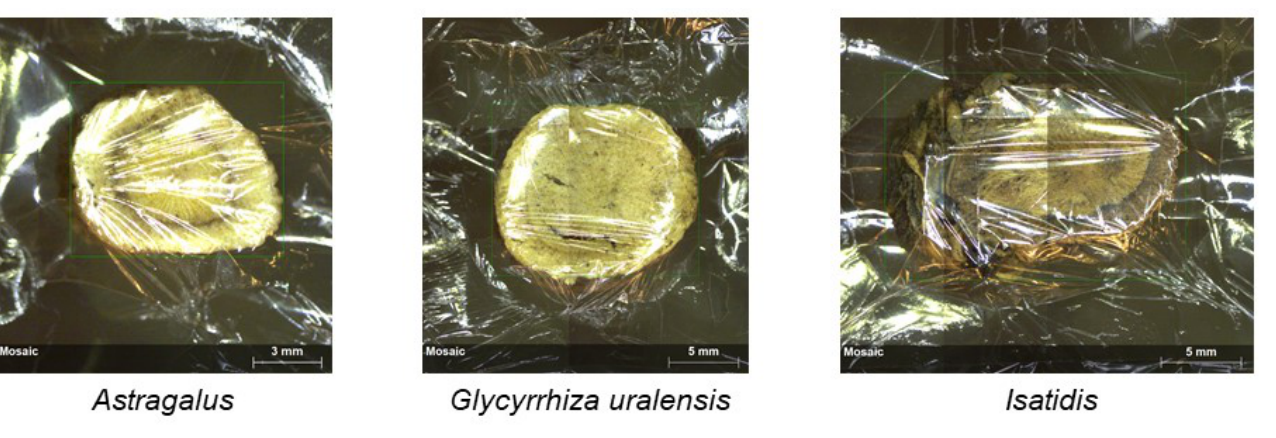
Figure 1. Experimental herbal